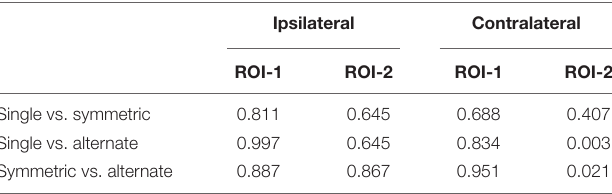
TABLE 2 | P values from post hoc analysis (least significant difference) for the 3-way interaction (ROI × laterality × leg-swing condition). Ipsilateral Contralateral ROI-1 ROI-2 ROI-1 ROI-2 Single vs. symmetric Single vs. alternate Symmetric vs.